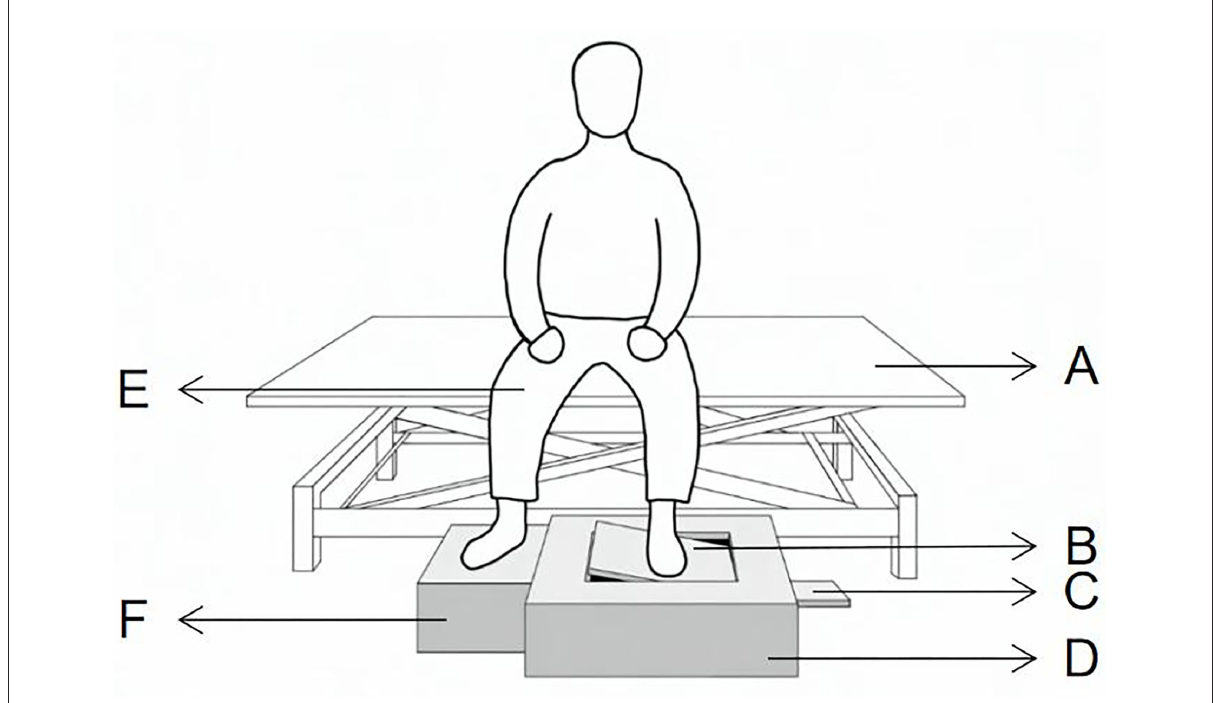
FIGURE1 Active movement extent discrimination apparatus for assessing ankle proprioceptive acuity in the sitting position. (A) the adjustable Bed, (B) movable foot platform, (C) adjustable panel, (D) AMEDA main body, (E) knees flexed at 90 ◦ , (F) stationary foot